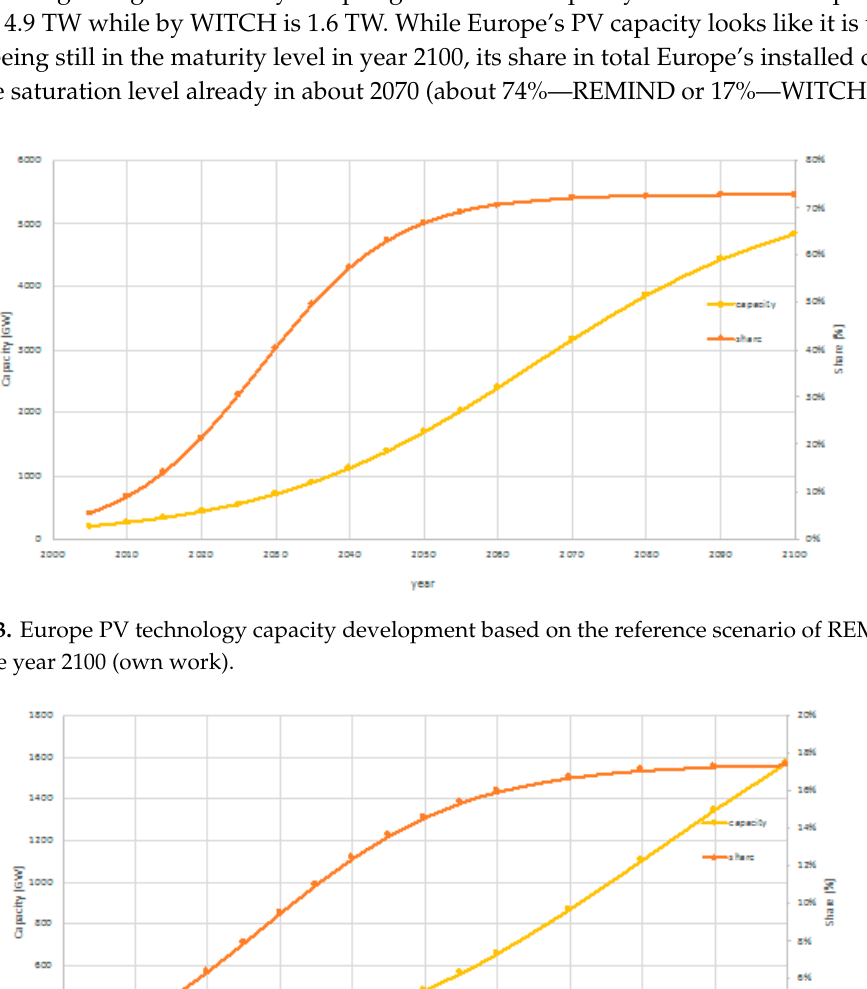
Table 6. Parameters calculated for the S-shaped PV curves (Figures 3 and 4).